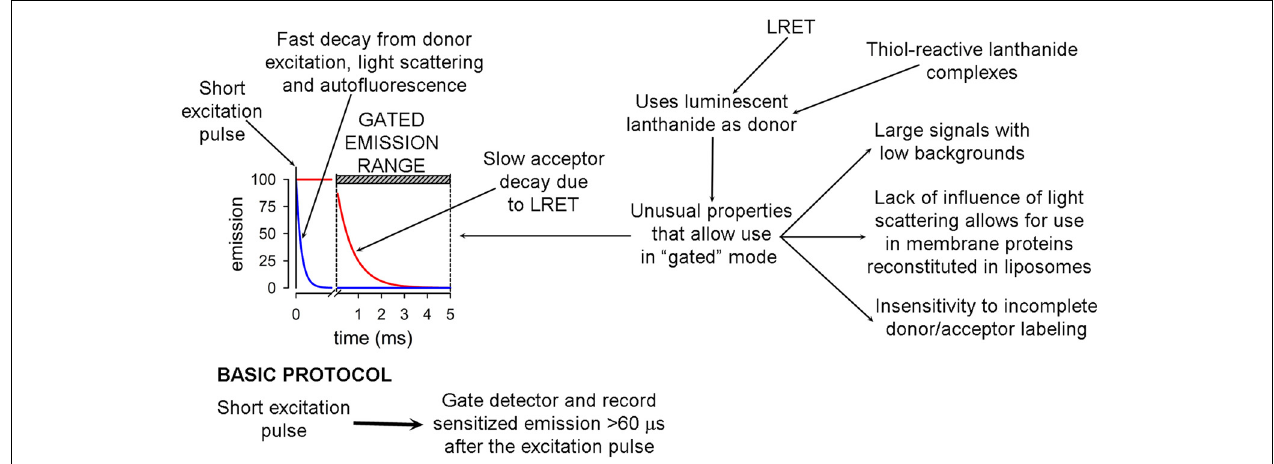
FIGURE 5 | Basic principles and advantages of luminescence resonance energy transfer. The basic gated-mode LRET protocol that takes advantages of the long lifetime of the donor compared to the fluorophore acceptor is summarized at the bottom.